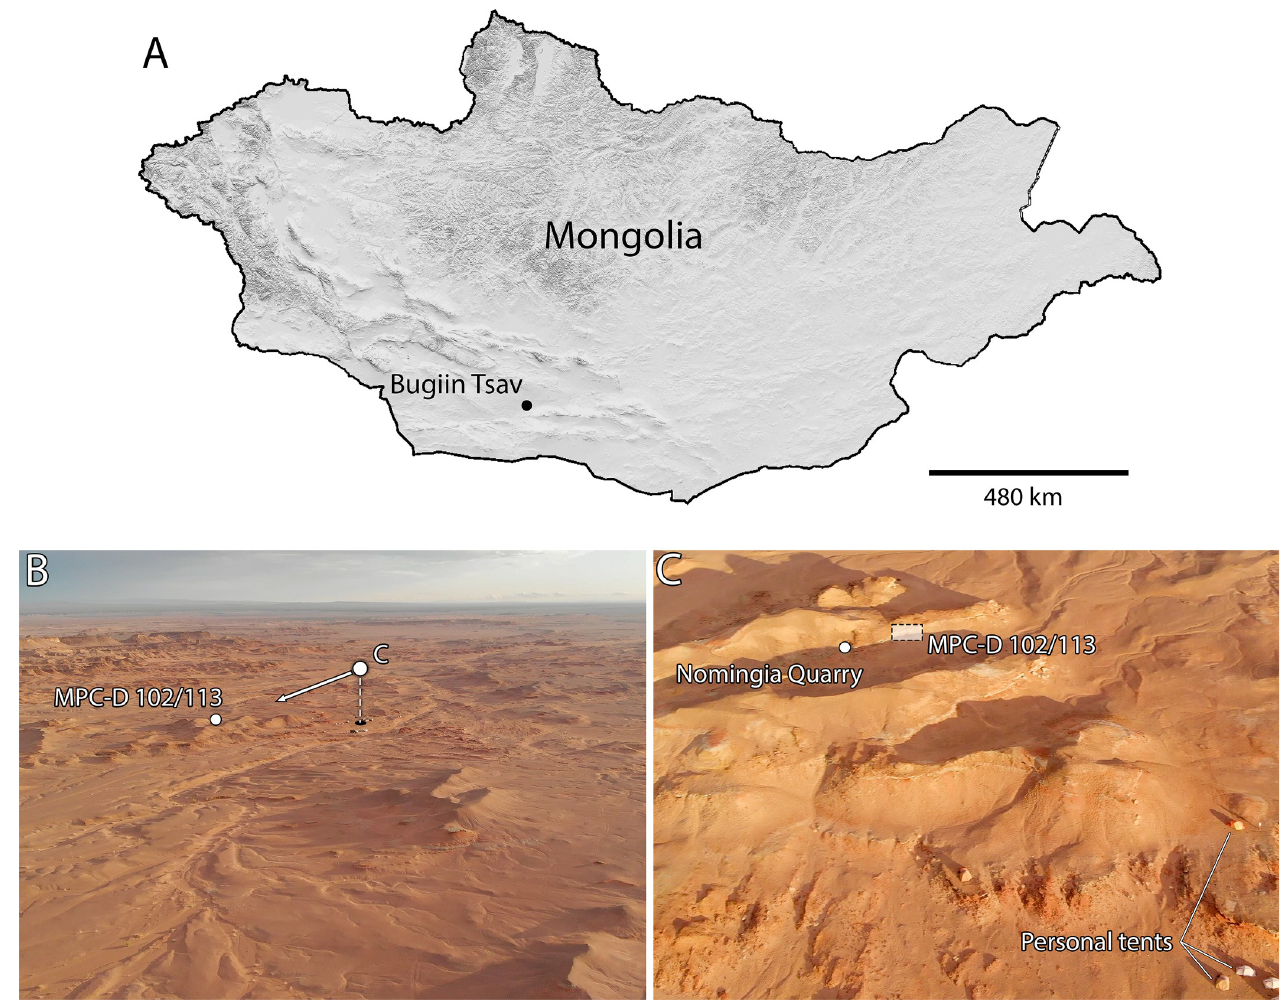
Fig 1. Location of the Bu¨giin Tsav locality and “ Nomingia gobiensis” type quarry. A , Topographic of Mongolia showing the Bu¨giin Tsav region in the Ingenii Ho¨o¨vo¨r Basin. Map data from USGS National Map Viewer (Public Domain). B , Aerial image of Bu¨giin Tsav looking southeast, showing the site where MPC-D 102/113 was collected, and the orientation of the aerial image (C). C , aerial image of the site of MPC-D 102/113 from above the 2018 Camp site, showing the proximity of the site to the type quarry of “ Nomingia gobiensis” . Note single-person tents in bottom right for